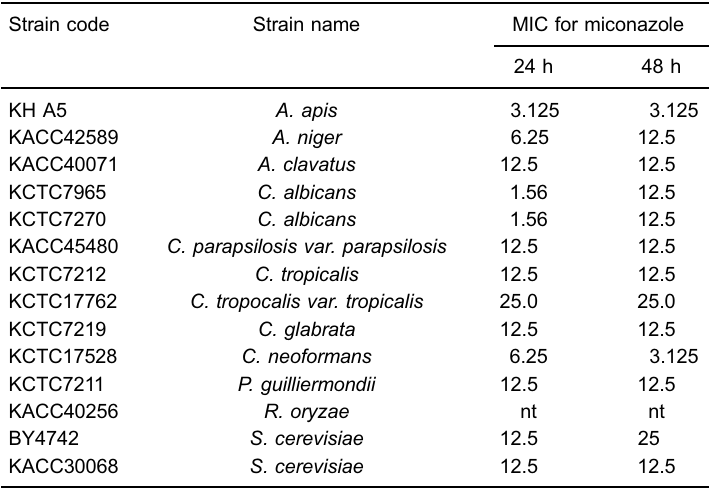
Table 5 . In vitro susceptibility of fungi to miconazole at 24 and 48 h. Strain